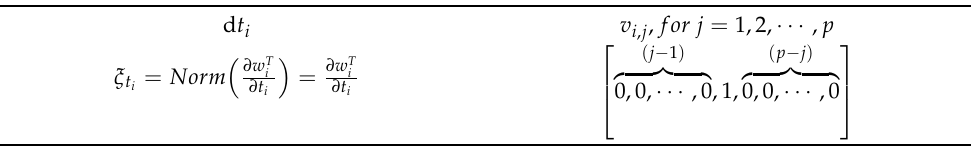
Table 1. ξ for VFCSS applying over crisp numbers.